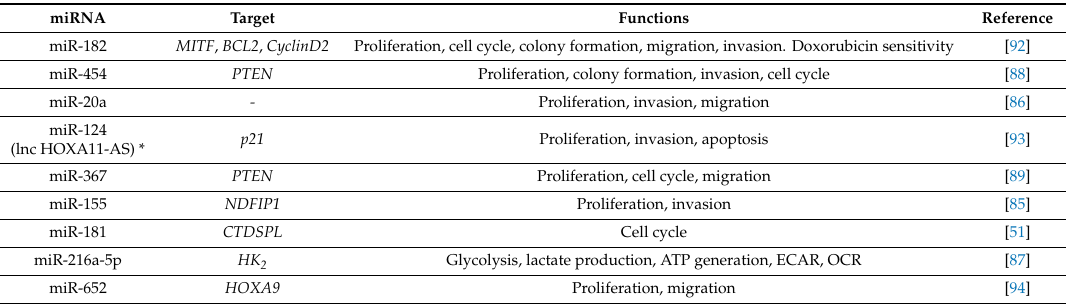
*: Denotes microRNAs (miRNAs) that are regulated by long-noncoding RNAs (lncRNAs). ATP – adenosine triphosphate, ECAR – extracellular acidification rate, OCR – oxygen consumption